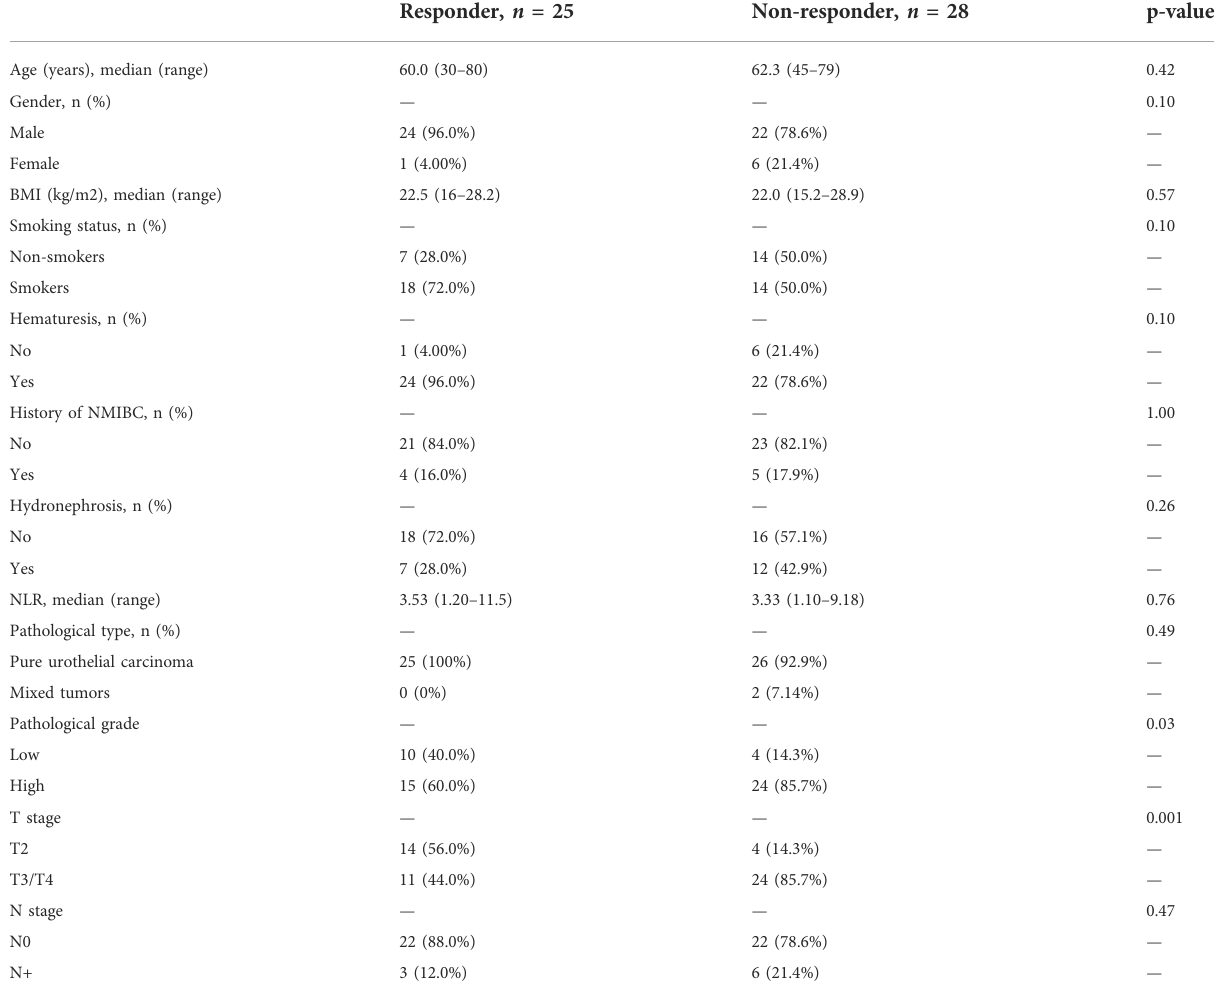
TABLE 1 Comparison of baseline clinicopathologic variables between neoadjuvant chemotherapy (NAC) response and non-response groups. Responder, n =